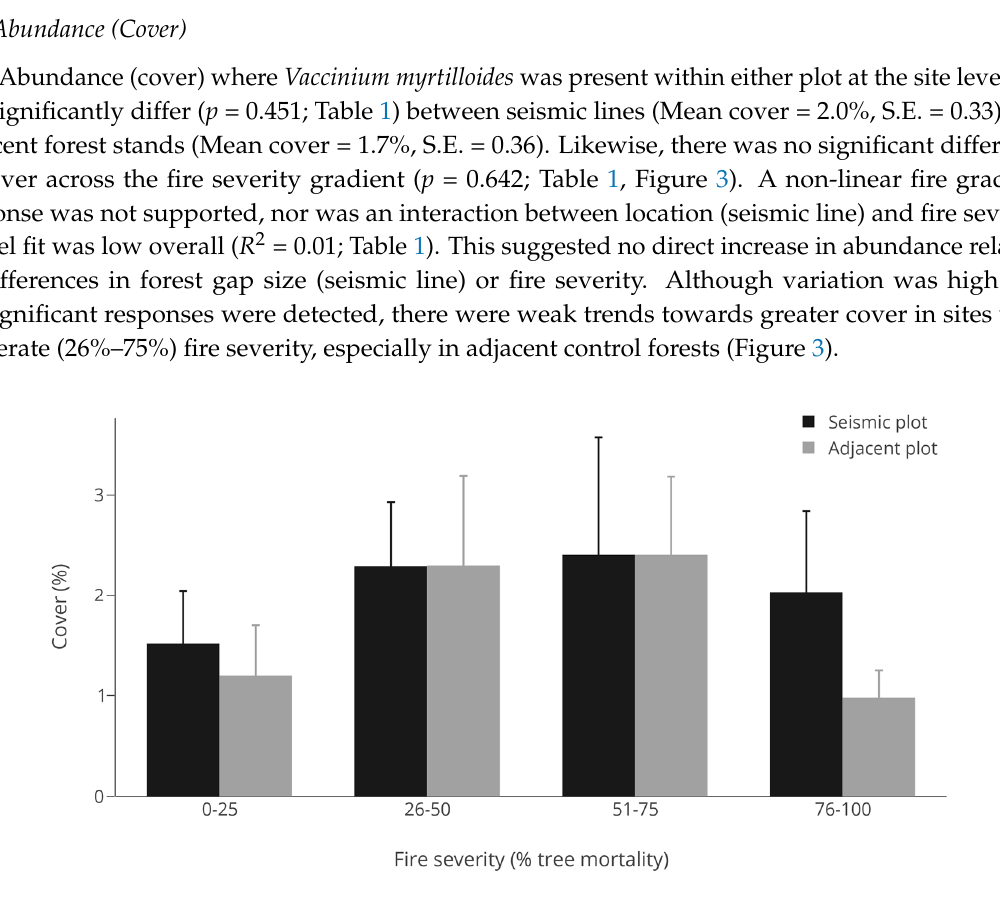
Figure 3. Mean cover of Vaccinium myrtilloides when present for seismic lines and adjacent forests across a fire severity gradient. Comparisons between seismic and adjacent plots within fire severity classes were tested using paired t -tests revealing no significant ( p < 0.1) differences.